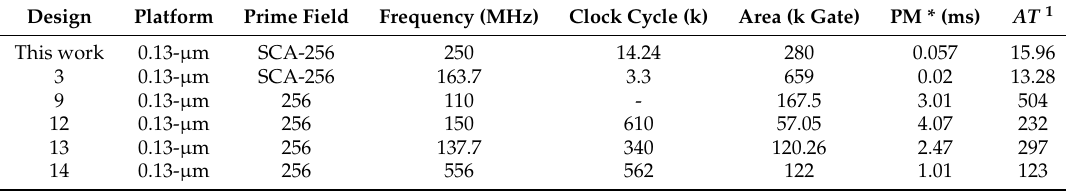
Table 4. ECC hardware performance comparison on ASIC